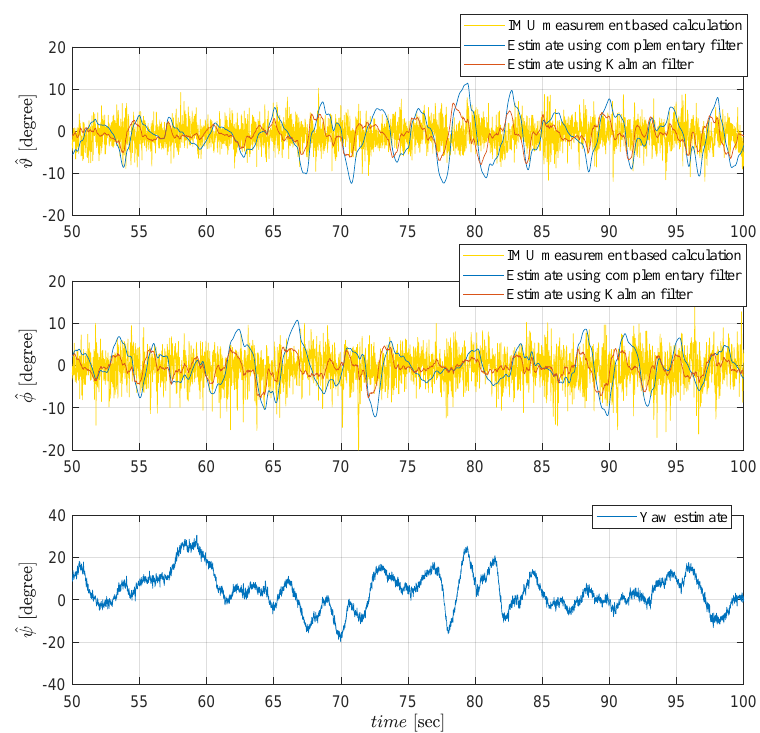
Figure 9. Attitude angle estimation of the Qball-X4 from 50 to 100